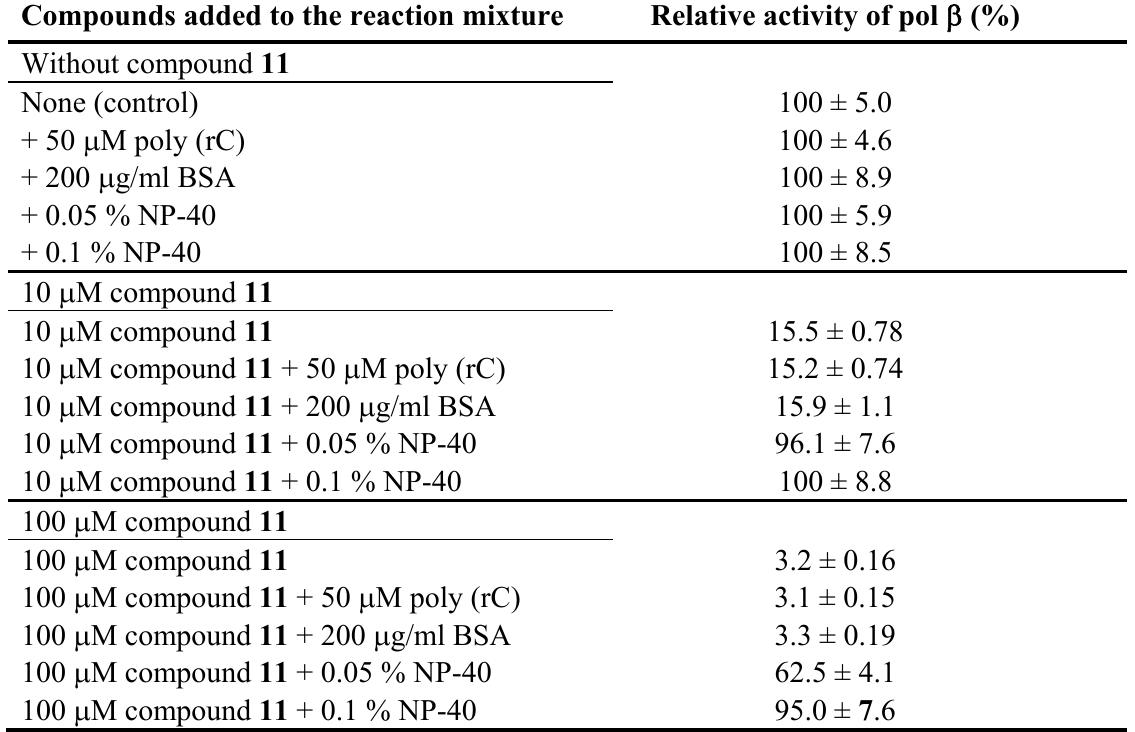
Table 2. Effects of poly (rC), bovine serum albumin (BSA) or Nonidet P-40 (NP-40) on the inhibition of rat DNA polymerase β activity by compound 11